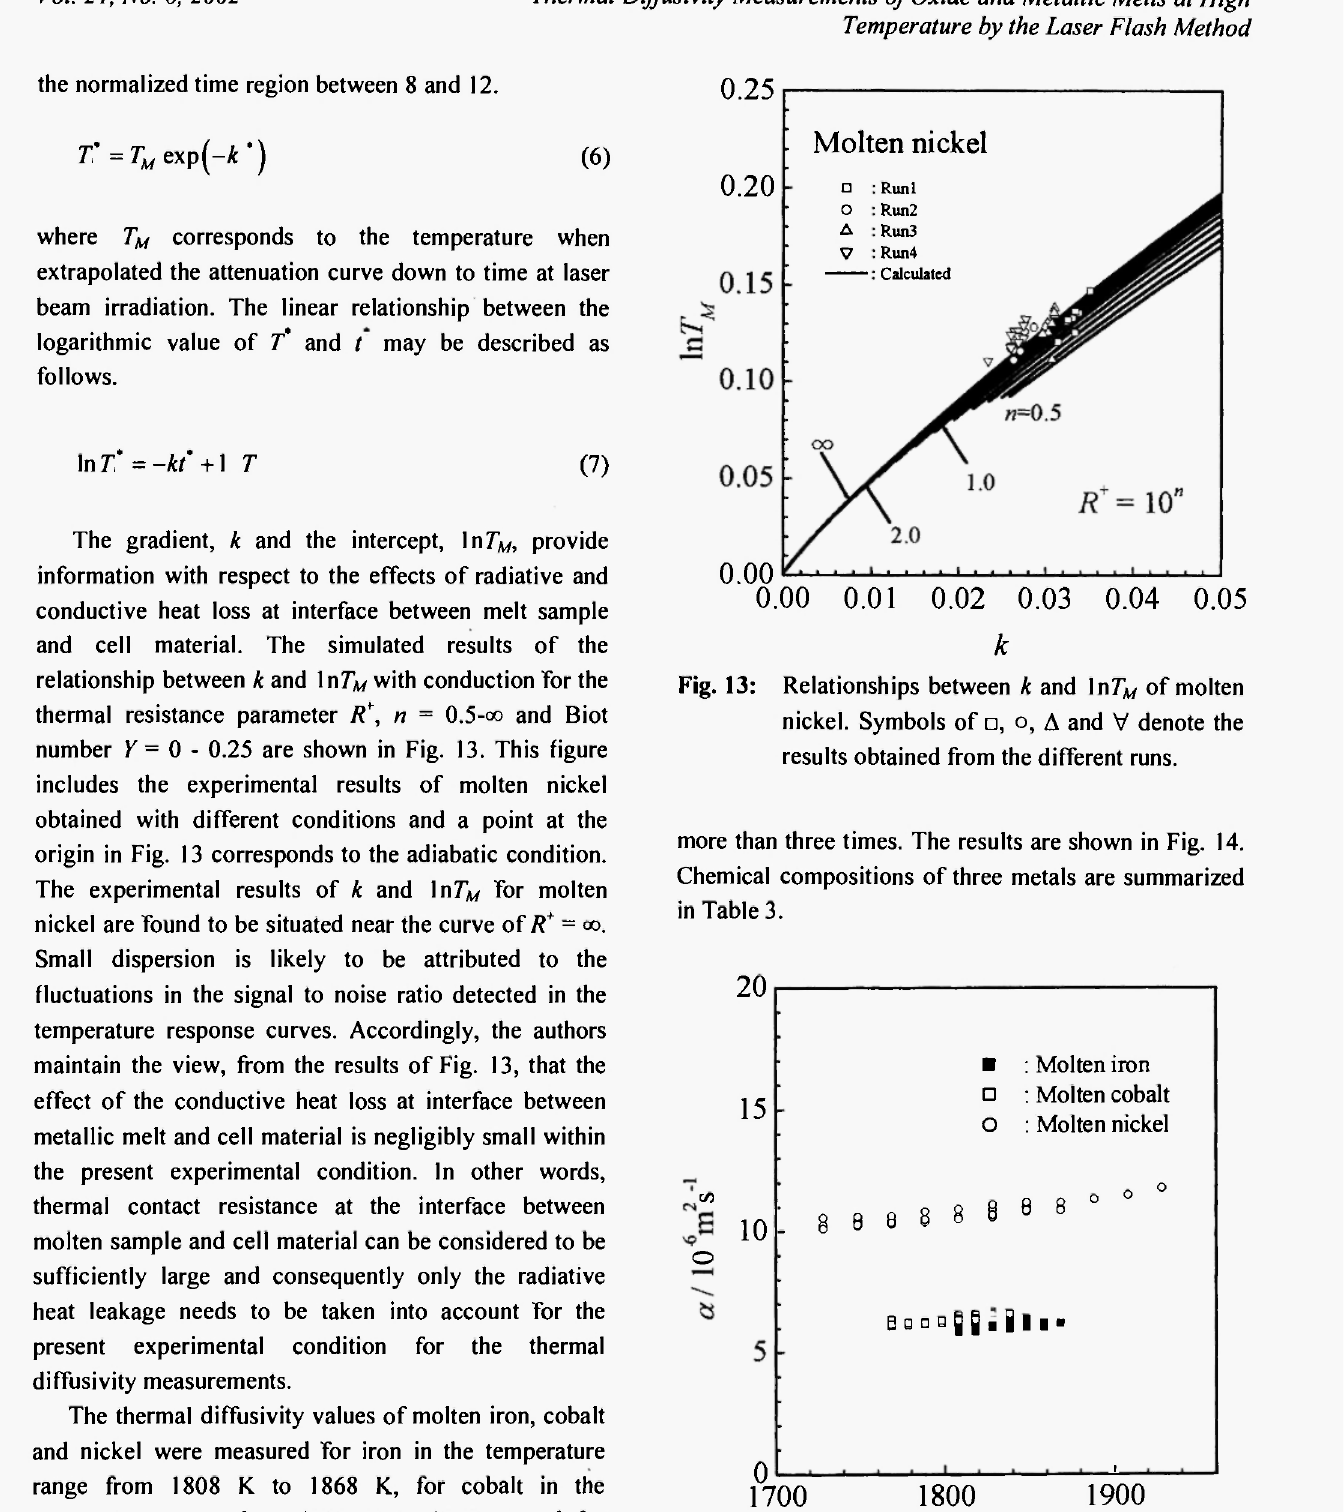
Thermal diffusivity of molten iron, cobalt and nickel as a function of temperature obtained in this